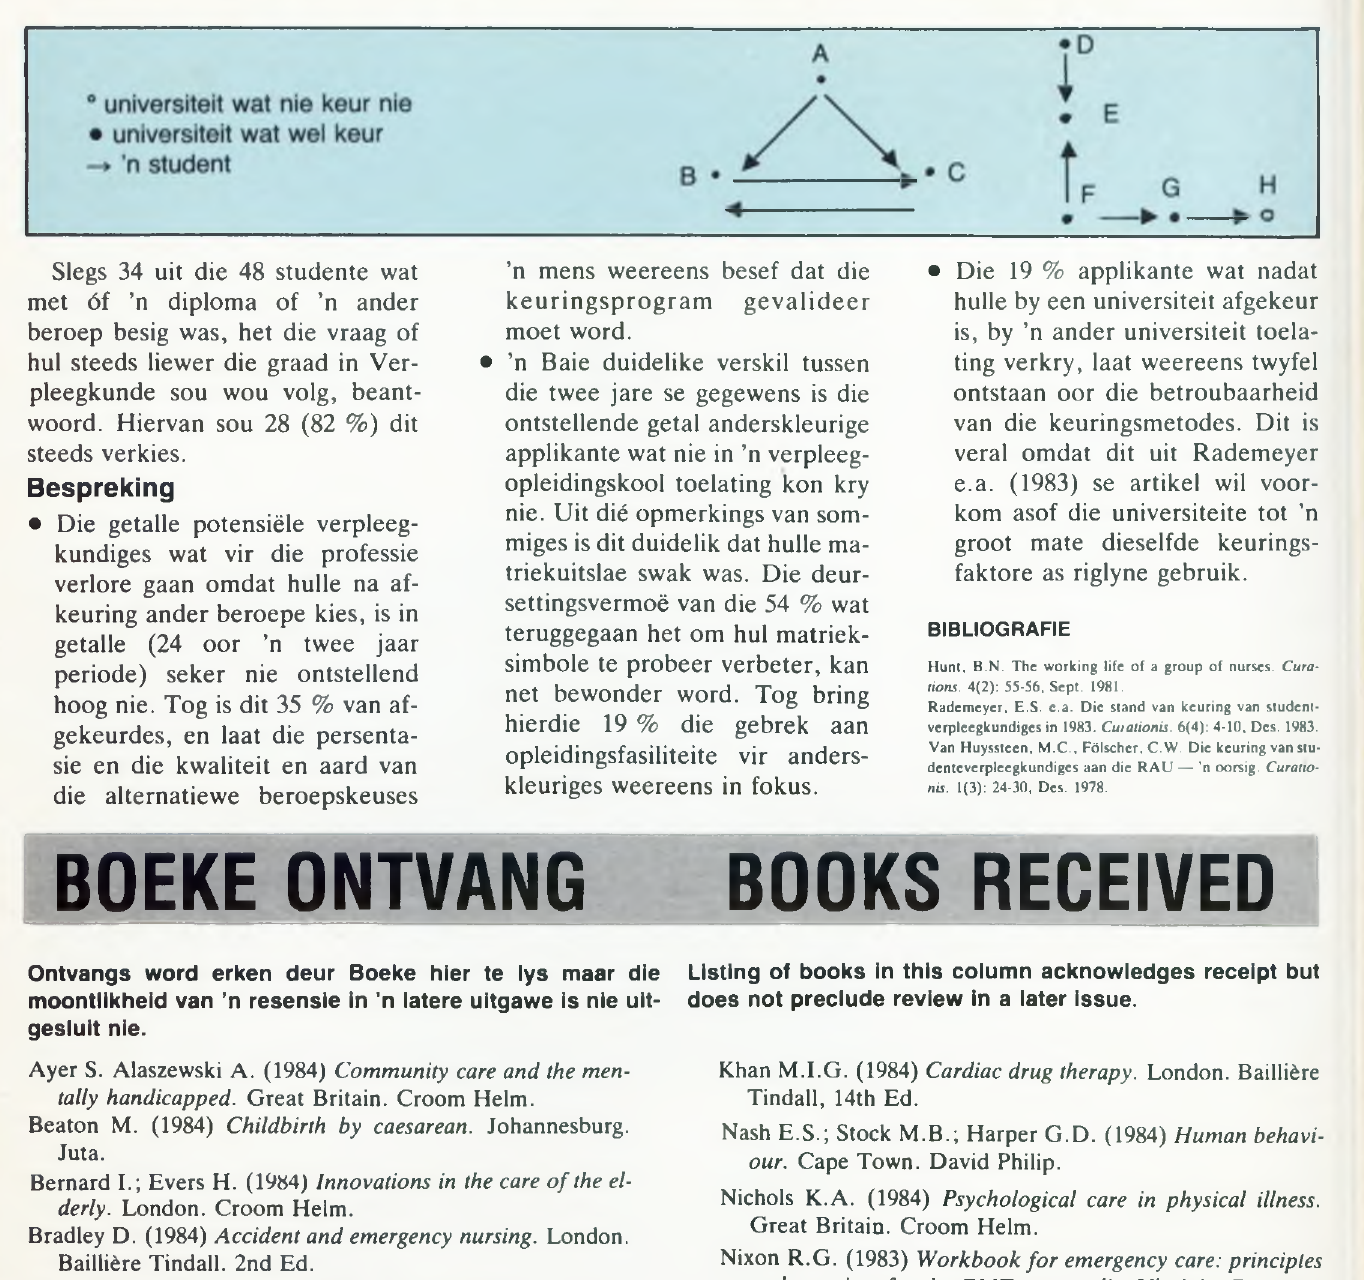
Figuur 3: Beweging van ongekeurdes na ander universiteite